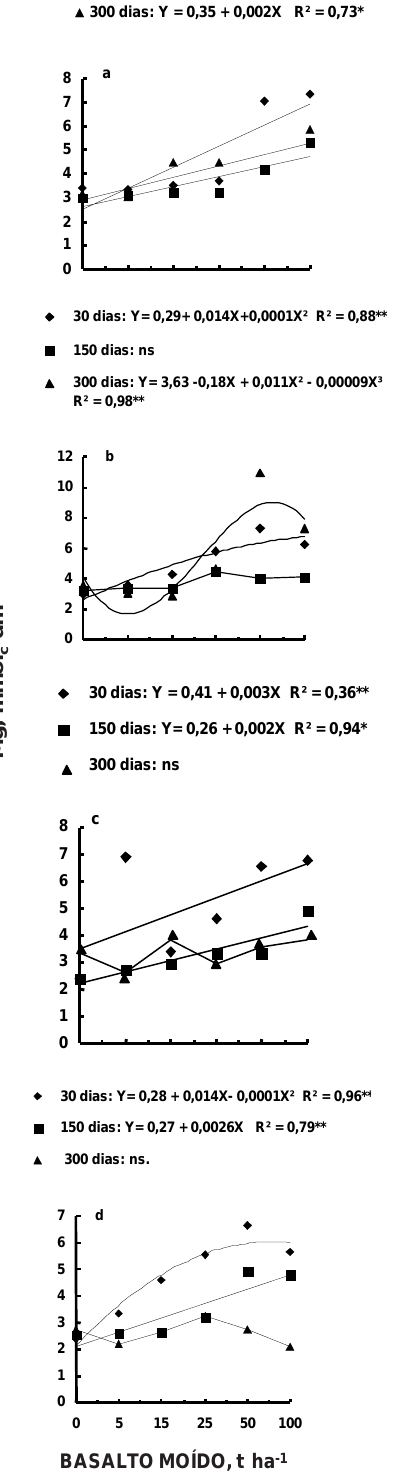
Figura 3. Concentração de Mg trocável em um Latossolo Vermelho-Escuro e em um Podzólico Vermelho-Amarelo, incubados com doses crescentes de basalto microcristalino (respectivamente, figura 3a, c) e de olivina-basalto (respectivamente, figura 3b, d), após 30, 150 e 300 dias de